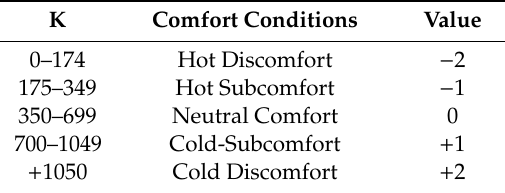
Table 5. Siple and Passel Index: Cooling power of the wind (K) and comfort conditions.